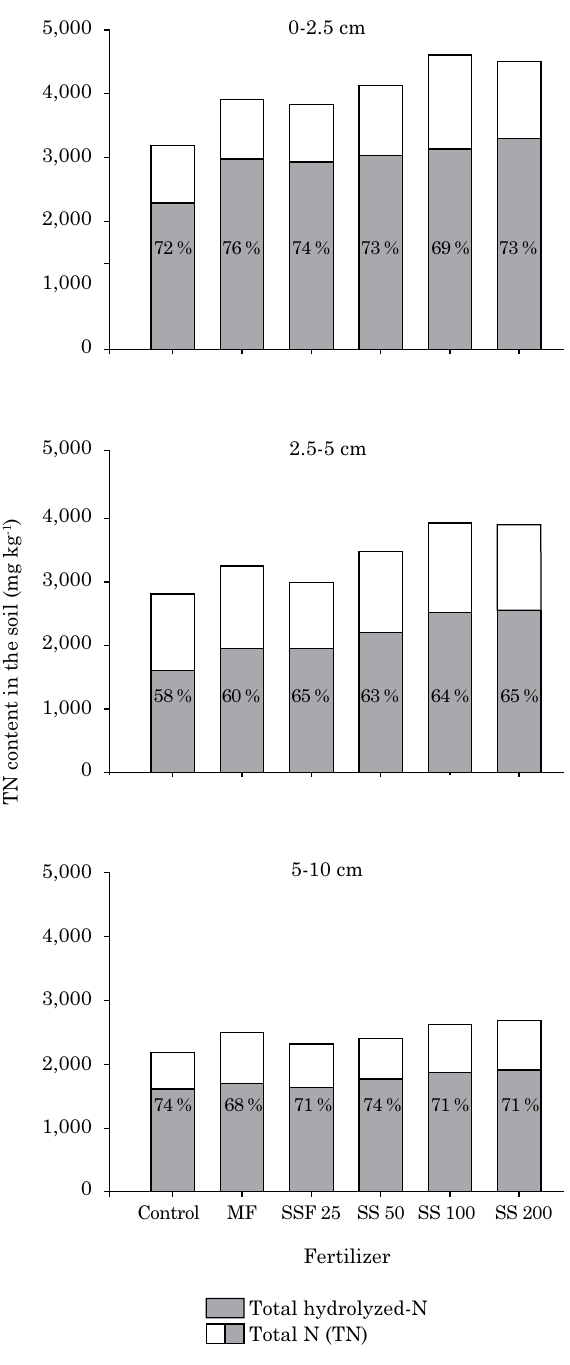
Figure 1. Total nitrogen content (Tn) and total hydrolyzed-n content in 6 mol l -1 HCl, and respective percentage of the latter in relation to the former in the 0-2.5, 2.5-5, and 5-10 cm depth layers in a latossolo Vermelho distroférrico (Typic Hapludox) subjected to 10 years of annual fertilization with mineral fertilizer (mF) and pig slurry (SS) at the rates of 0 (control), 25, 50, 100, and 200 m -3 ha -1 in a no-till system. mean values of four